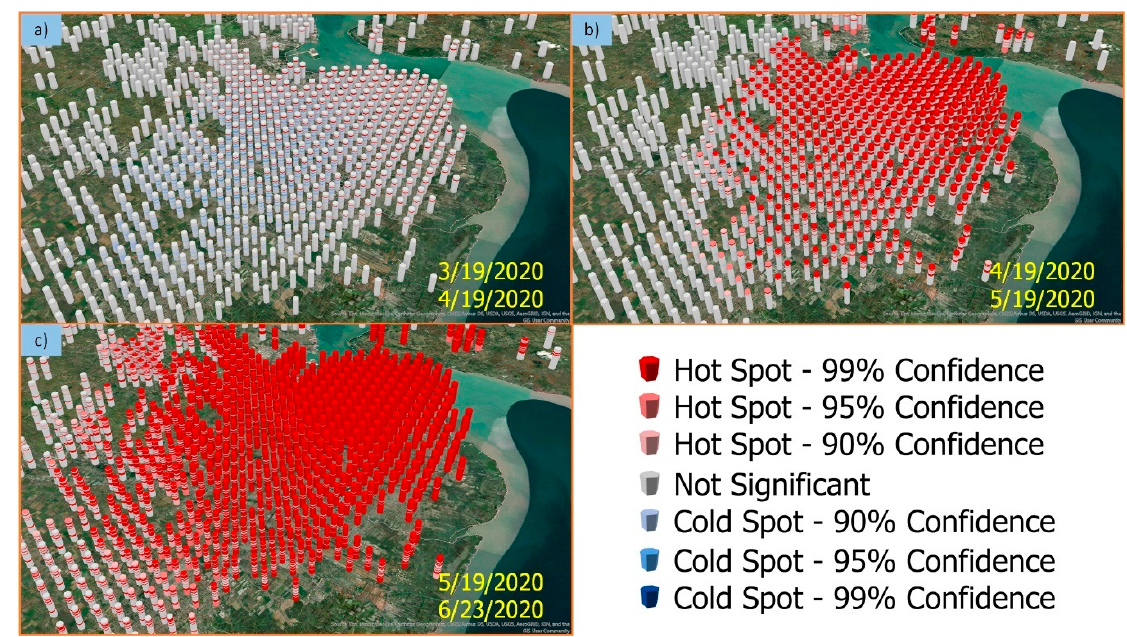
Figure 5. A 3D visualization of STC for COVID-19 hotspots in Surabaya Raya. ( a ) Phase 1 from 19 March 2020 to 19 April